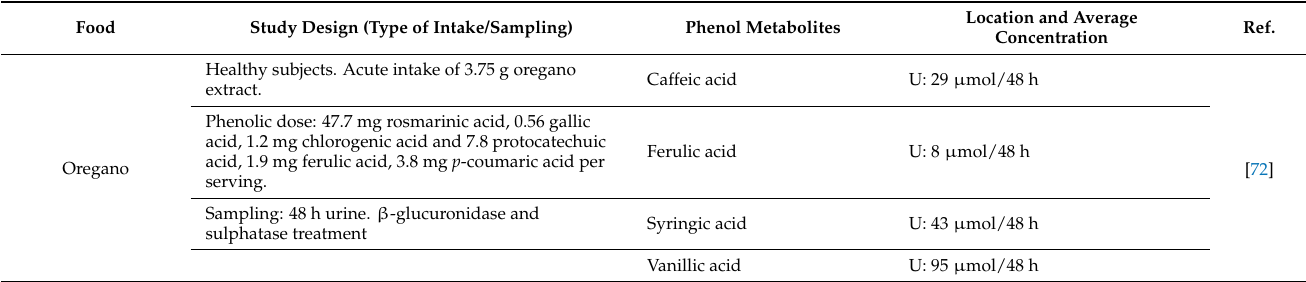
Table 5. Phenolic metabolites (phase I, phase II) proposed as intake biomarkers of aromatic herbs and nuts commonly consumed in the Mediterranean